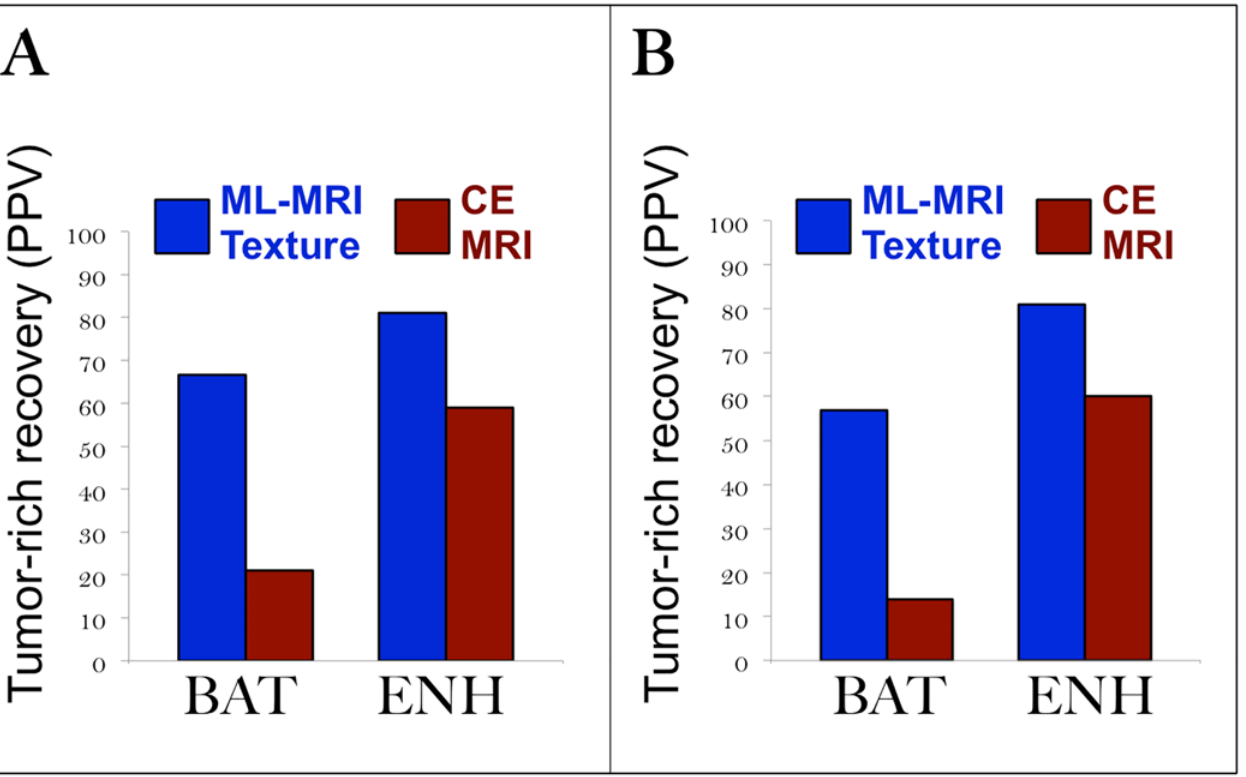
Fig 2. ML-based model improves tumor-rich biopsy delineation compared with CE-MRI. (A) ML-based MRI texture model in the full dataset (n = 82, Table 1) shows higher positive predictive values (PPV) (66.7% in BAT, 81.3% in ENH) for recovering tumor-rich samples compared with CE-MRI (21.2% in BAT, 59.2% in ENH). These PPVs suggest that the ML-based model would help recover tumor-rich BAT samples with over three times greater efficiency compared with CE-MRI guidance. (B) ML-based MRI texture model in the subanalysis (n = 76, S2 Appendix) provides higher positive predictive values (PPV) (57.1% in BAT, 80.6% in ENH) for recovering tumor-rich samples ( > 80% tumor nuclei) compared with CE-MRI (13.8% in BAT, 59.6% in ENH). Based on these PPVs, the ML-based model would enable four times more efficient tumor-rich recovery from BAT compared with CE-MRI guidance.